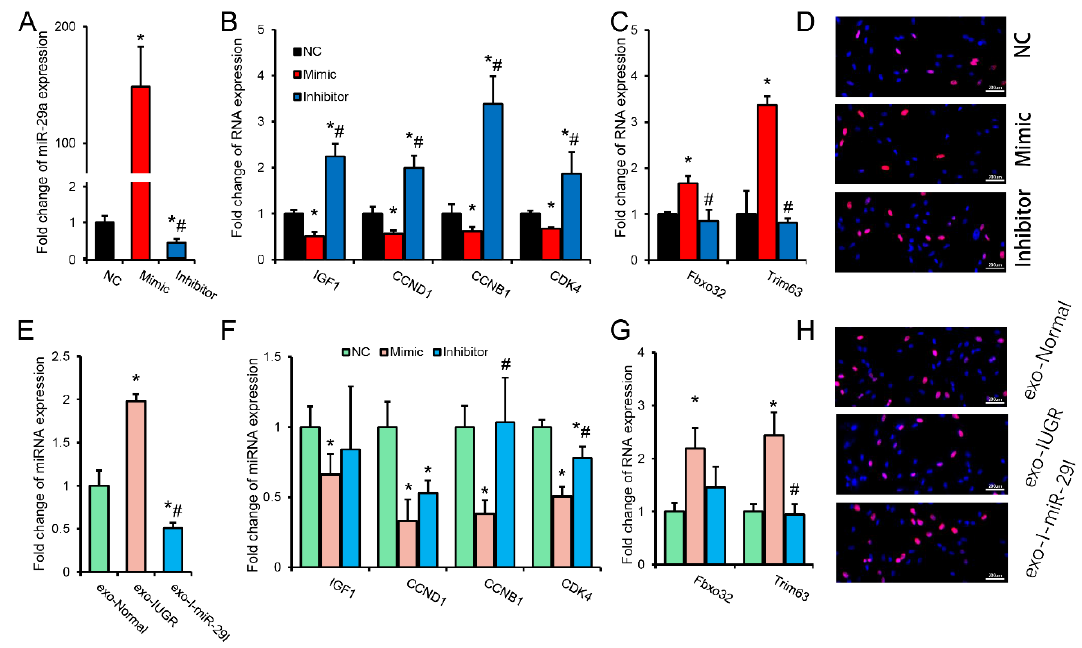
Figure 7. miR-29a is involved in the regulation of umbilical cord blood miRNAs in skeletal muscle cells in vitro. ( A ) The relative expression of miR-29a in pig primary skeletal muscle cells after transfection with miR-29a mimic or miR-29a inhibitor; ( B ) The relative expression of IGF1, CCND1 CCNB1, and CDK4 in pig primary skeletal muscle cells after transfection with miR-29a mimic or miR-29a inhibitor; ( C ) The relative expression of Fbxo32 and Trim63 in pig primary skeletal muscle cells after transfection with miR-29a mimic or miR-29a inhibitor; ( D ) EdU staining results of porcine primary skeletal muscle cells after transfection with miR-29a mimic or miR-29a inhibitor; ( E ) The relative expression of miR-29a in porcine primary skeletal muscle cells after co-treatment with normal porcine umbilical cord blood exosomes (exo-Normal) or IUGR porcine umbilical cord blood exosomes (exo-IUGR) and miR-29a inhibitor (exo-I-miR-29I); ( F , G ) The relative expression of IGF1, CCND1 CCNB1, CDK4, Fbxo32, and Trim63 in porcine primary skeletal muscle cells after co-treatment with exo-Normal or exo-IUGR and exo-I-miR-29I; ( H ) EdU staining results of porcine primary skeletal muscle cells after co-treatment with exo-Normal or exo-IUGR and exo-I-miR-29I. N = 3. * p -value < 0.05 vs NC, # p -value < 0.05 vs Mimic.